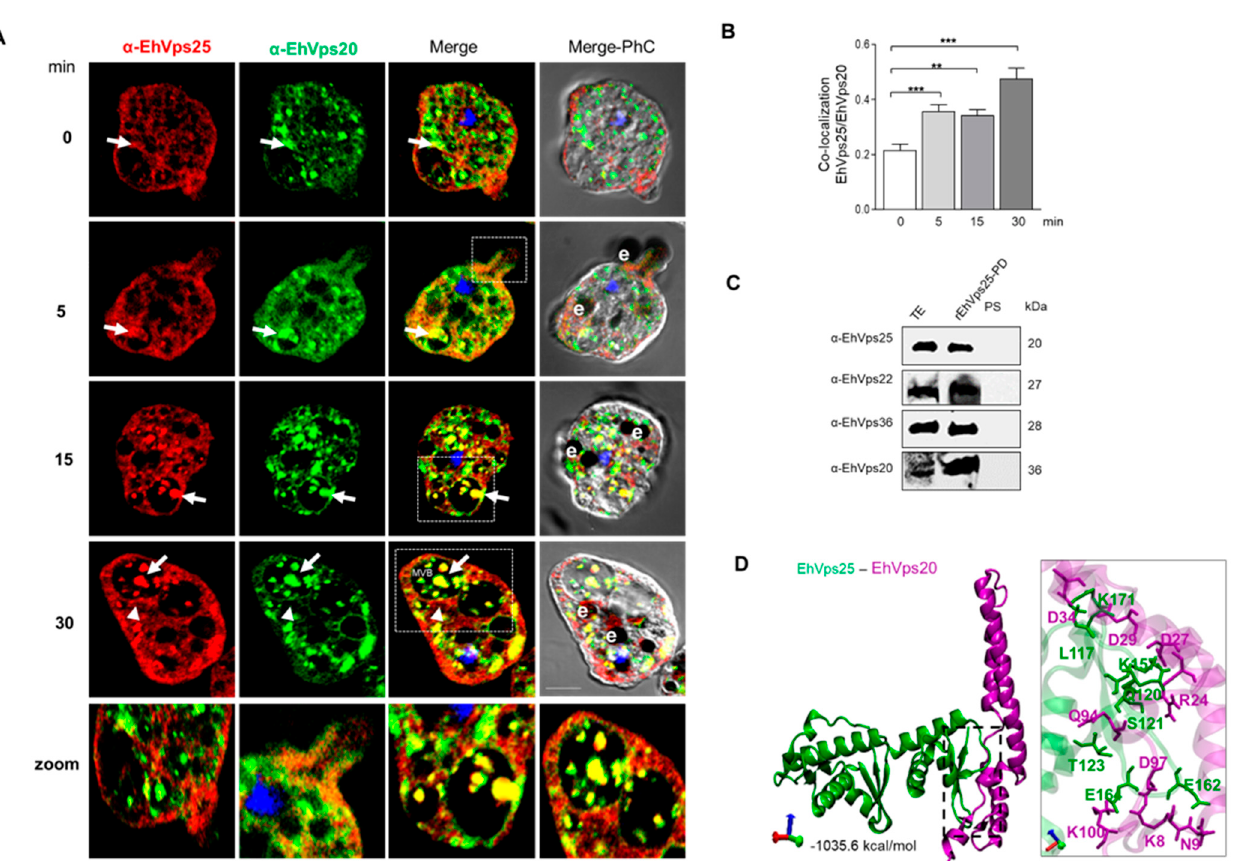
and negative controls. TE: total extracts; NRP: non-recombinant protein. Right panel: western blot assay of pull-down assays using α -EhVps36 for precipitation and α -EhVps22, α -EhVps25, and α - EhVps23 antibodies to detect the associated proteins. rEhVps36-PD: pull-down sample PS: pre-im- mune serum. Numbers to the right: molecular weights. ( D ) Molecular docking between EhVps36 and EhVps23. The inset shows a magnification of the predicted amino acids involved in protein– protein interaction.